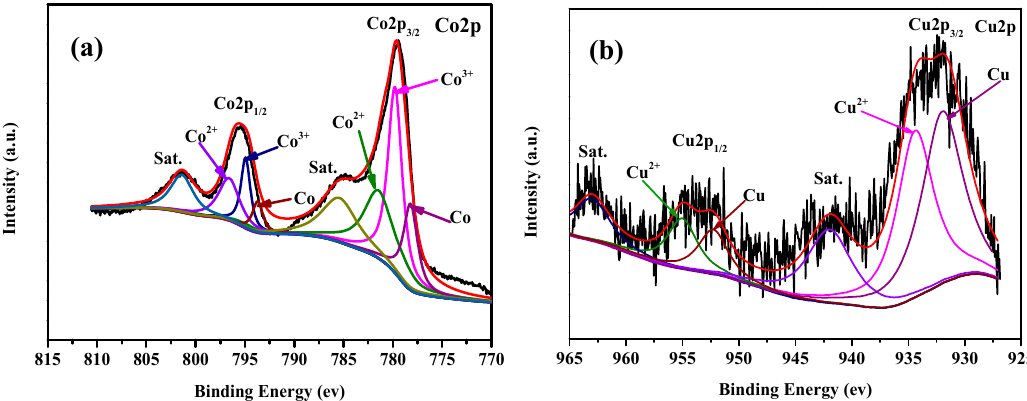
Figure 8. XPS specta of the CuCo 2 O 4 catalyst in Co2p ( a ) and Cu2p ( b ) regions after catalytic reaction.